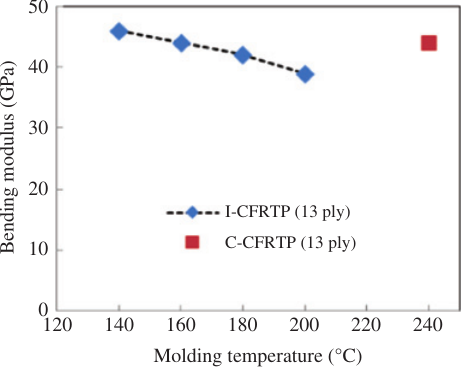
Figure 11 Results of the three-point bending tests for I-PA6 and C-PA6.